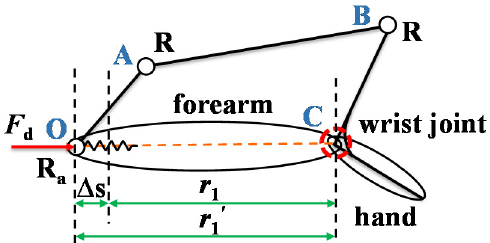
Figure 10. Model of four-bar linkage with compliance.